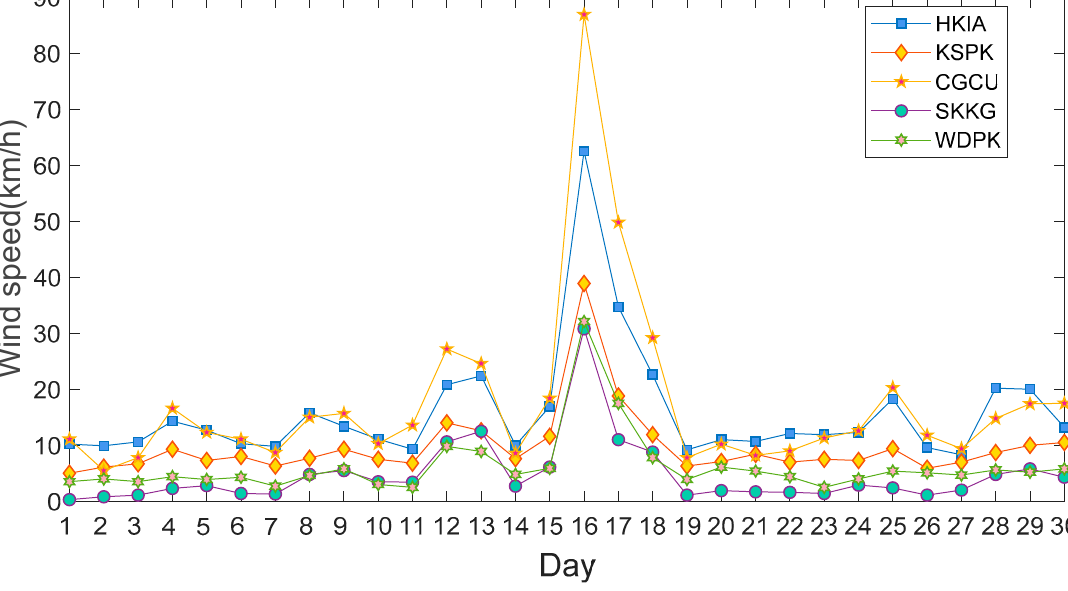
Figure 5. Daily mean wind speed over each weather station in September.